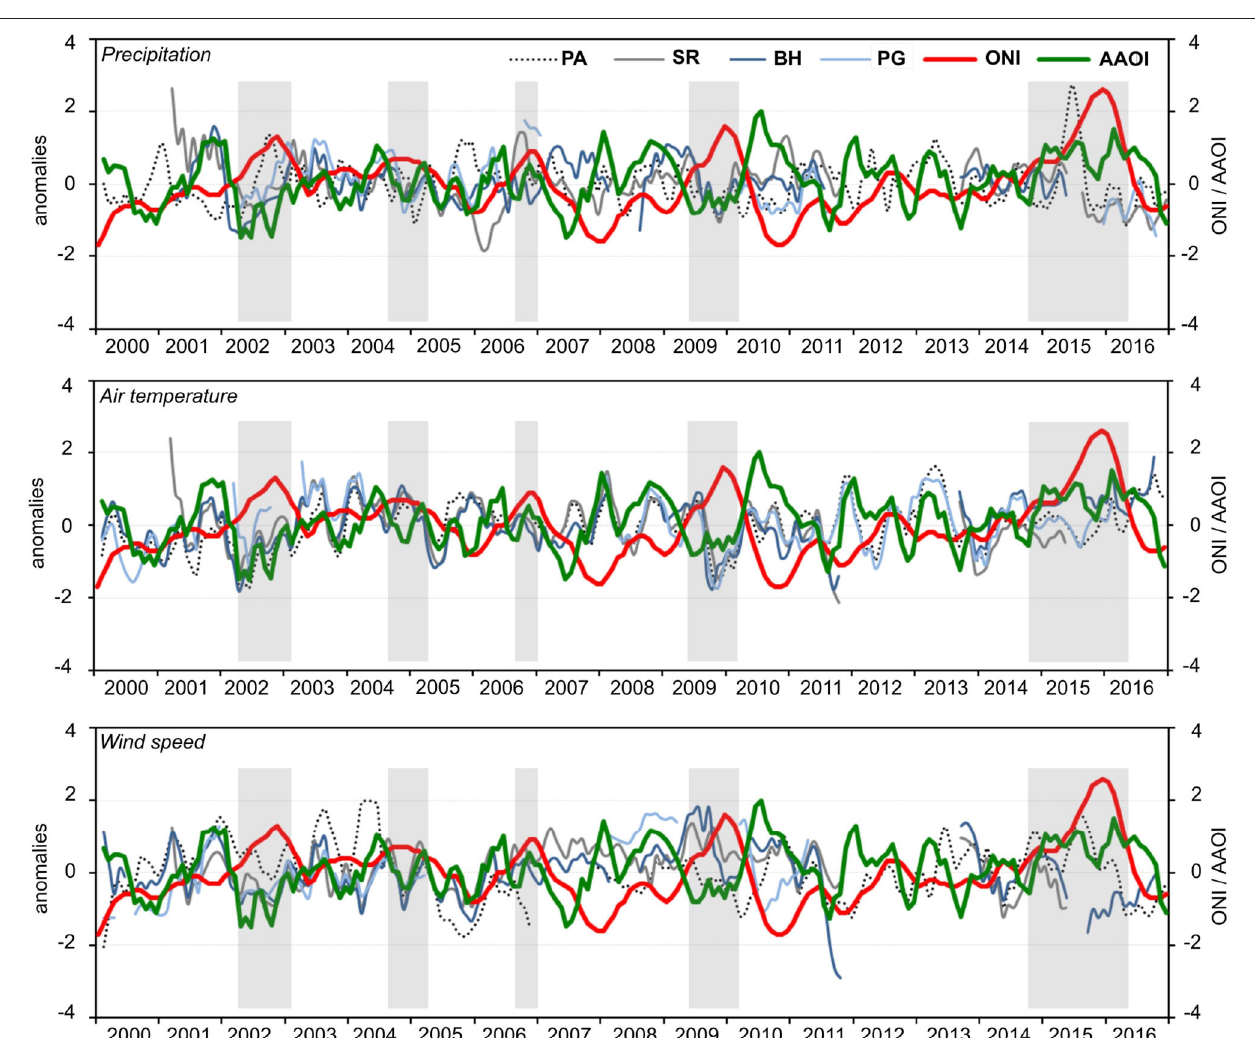
FIGURE 10 | Standardized monthly anomalies of precipitation, mean air temperature and wind speed at AWS Paso Galería (PG), AWS Puerto Bahamondes (BH), AWS Skyring (SR), and WS Punta Arenas (PA) and monthly ONI and AAOI values. El Niño events based on a threshold of +0.5 ◦ C for ONI are highlighted by the gray shading. Standardized monthly anomalies of climate variables are illustrated as a 3-month running